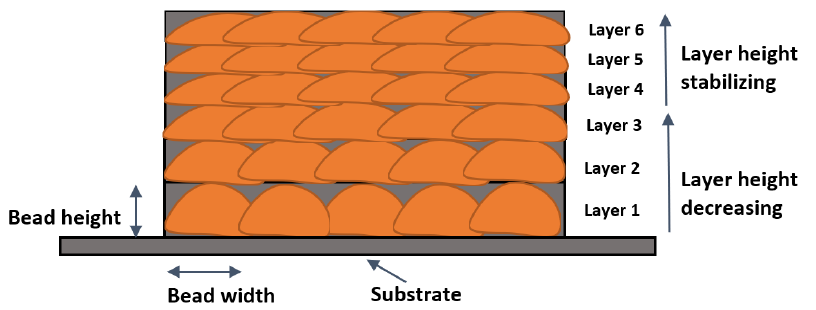
Figure 11. Schematic diagram of bead width and bead height for different deposited layers.